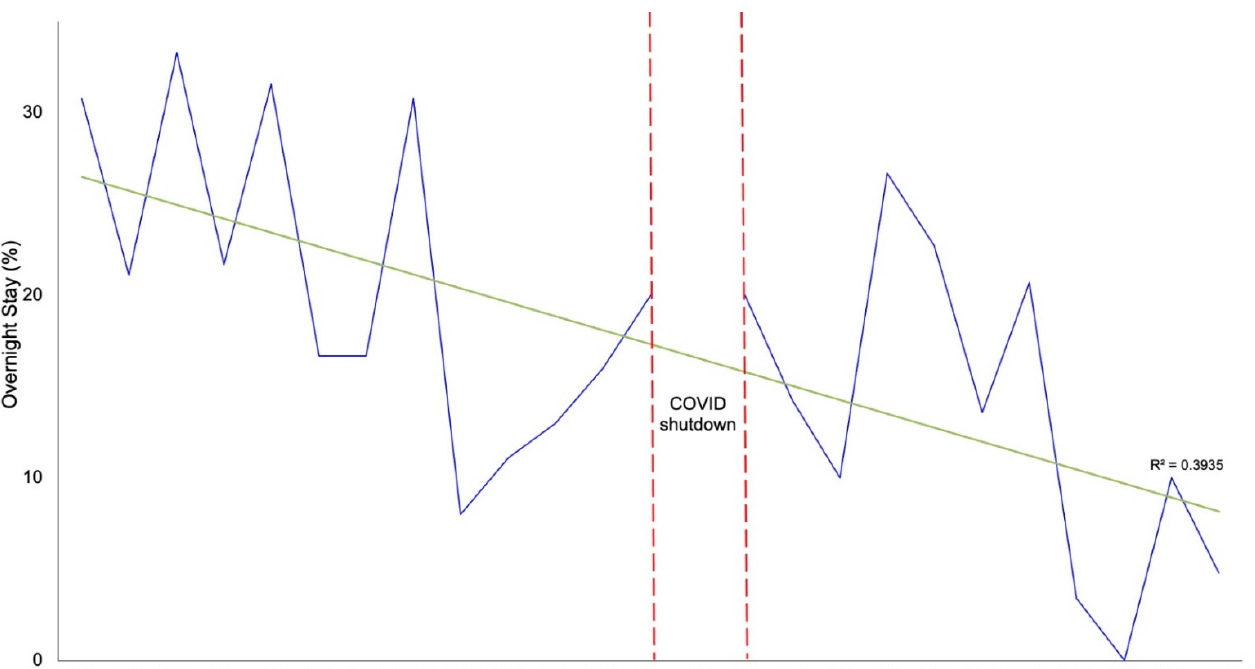
Figure 1. Outcomes after total shoulder arthroplasty in the pre- and post-COVID groups. Asterisks denote statistical sig- nificance ( p < 0.05).